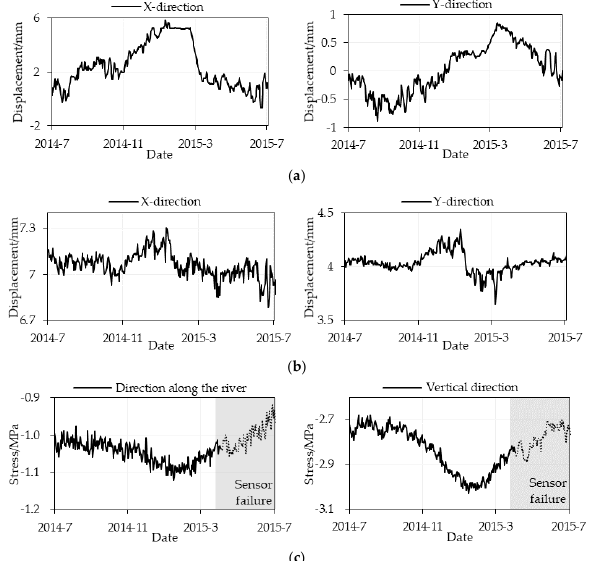
Figure 9. Time curves of the monitoring data (X-direction, Y-direction represent the direction along the river and the direction perpendicular to the river, respectively). The shaded area is the sensor failure period. ( a ) Vacuum laser alignment monitoring point LA9, ( b ) Inverted plumb line monitor- ing point IP3, and ( c ) Stress sensor S9.